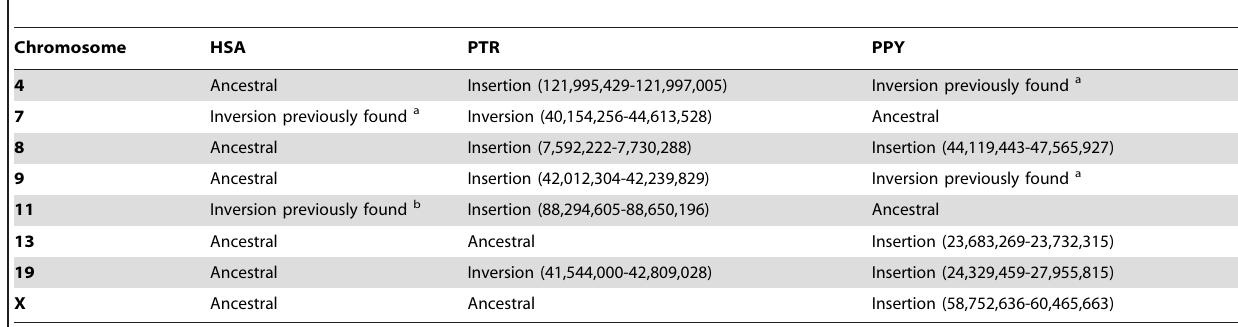
Table 2. Newly described reorganizations in human (HSA), chimpanzee (PTR) and orangutan (PPY) chromosomes.